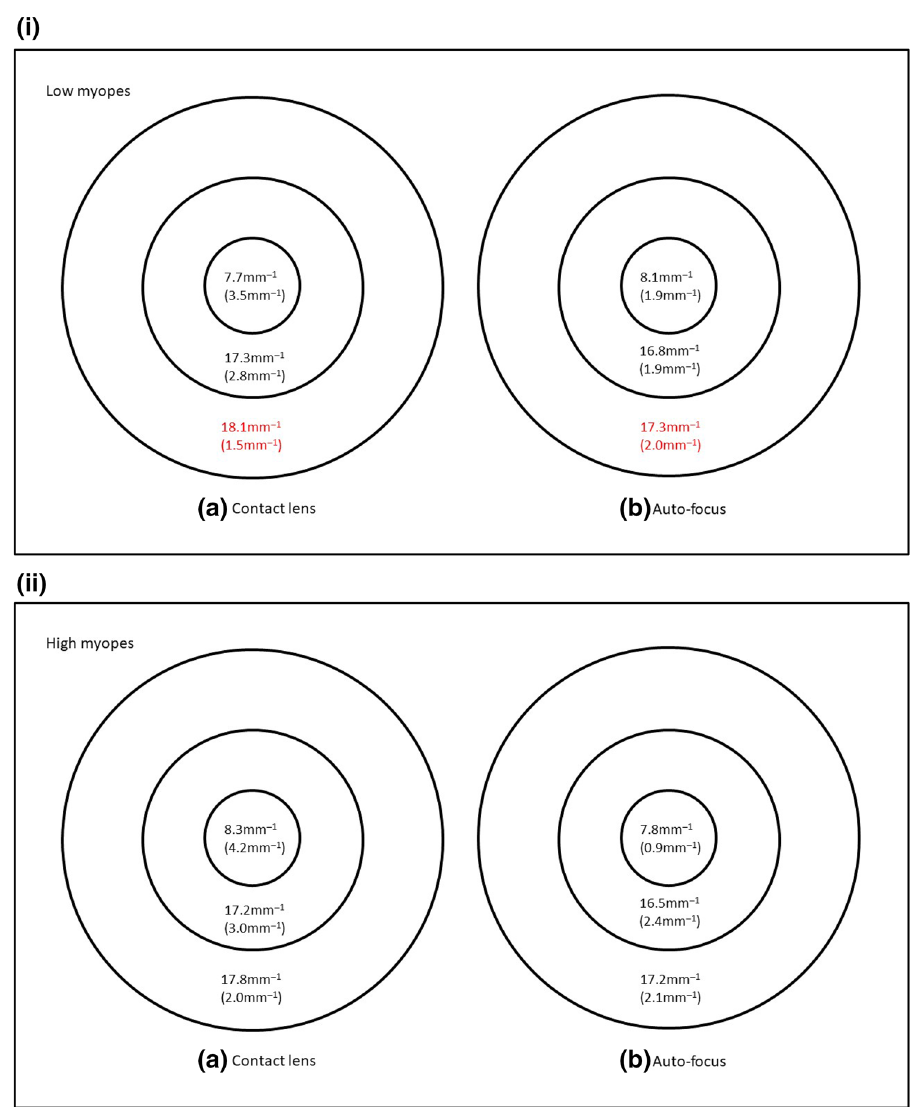
Figure 4. ( i ) Vessel length density of 34 eyes from low myopes when corrected with ( a ) contact lens and ( b ) the auto-focus system. Results are expressed as median (interquartile range) using the ETDRS central circle, inner and outer rings of the 6 mm grid. Significant difference between the two correction methods is marked in red. ( ii ) Vessel length density of 34 eyes from high myopes when corrected with ( a ) contact lens and b) the auto- focus system. Results are expressed as median (interquartile range) using the ETDRS central circle, inner and outer rings of the 6 mm